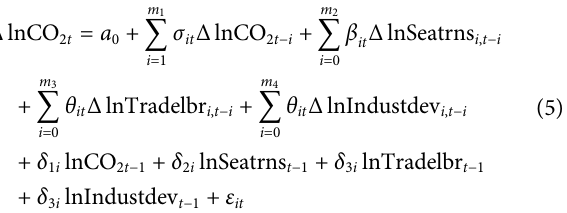
*Expressionde fi nestheunitroottestresultsofvariablesusedintheestimationprocessat 1% signi fi cance